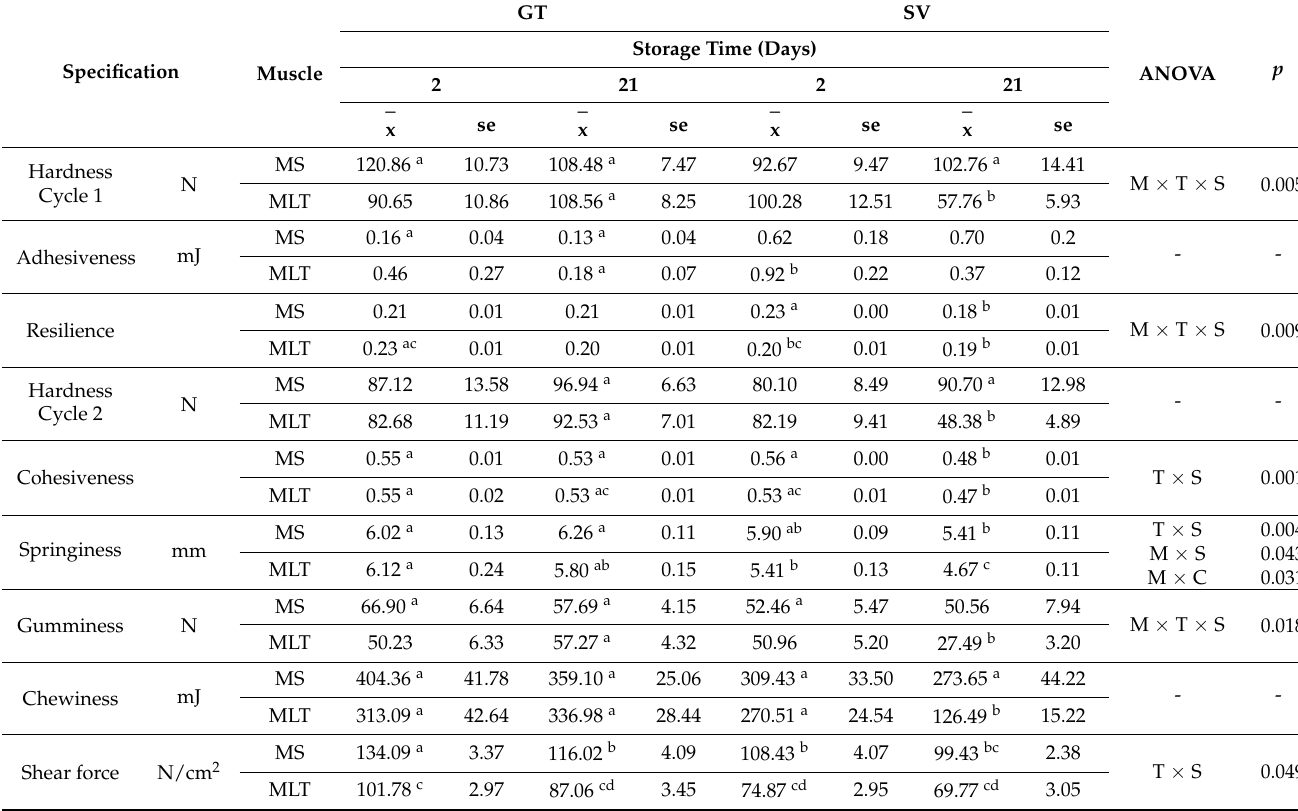
Table 3. Texture parameters of beef depending on the type of meat, cold storage time and thermal treatment used.